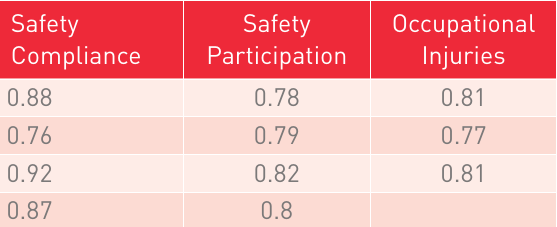
Loadings of the SP measurement model